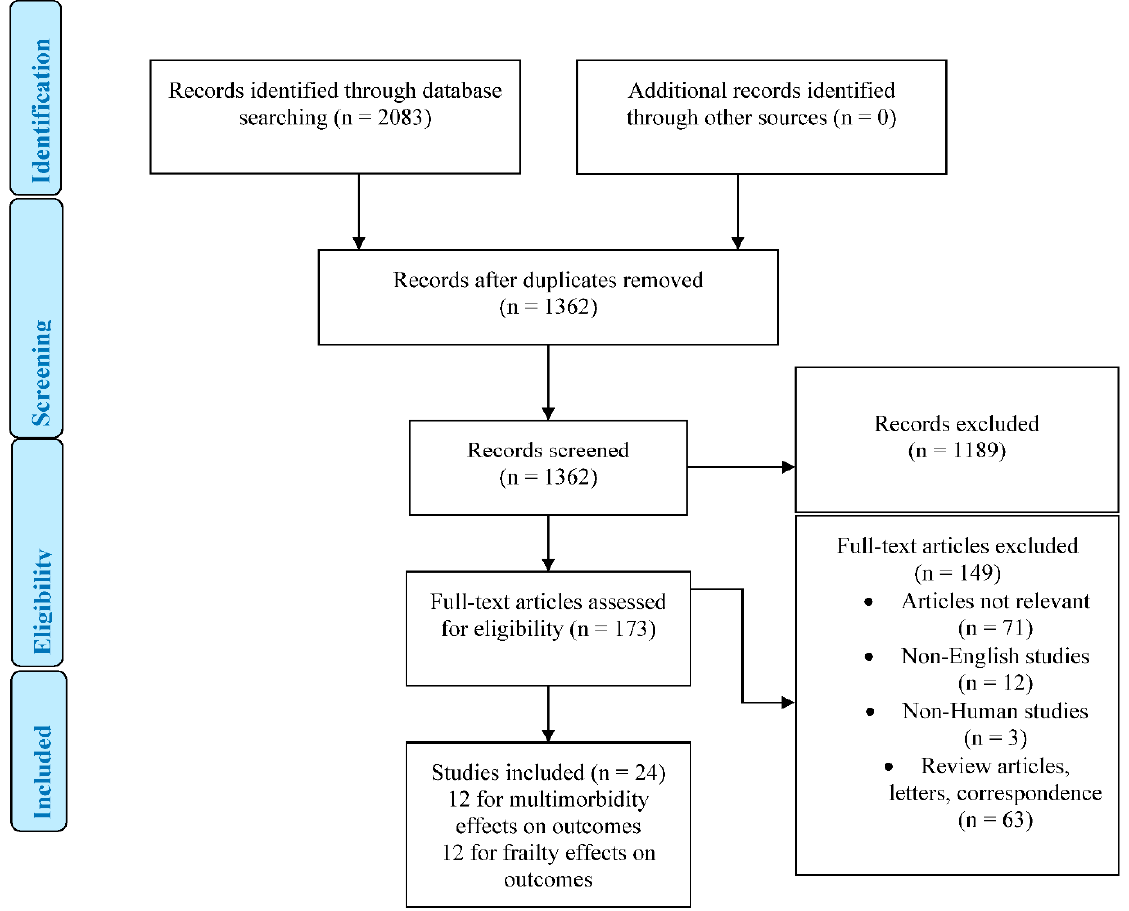
Figure 1. PRISMA flow diagram.